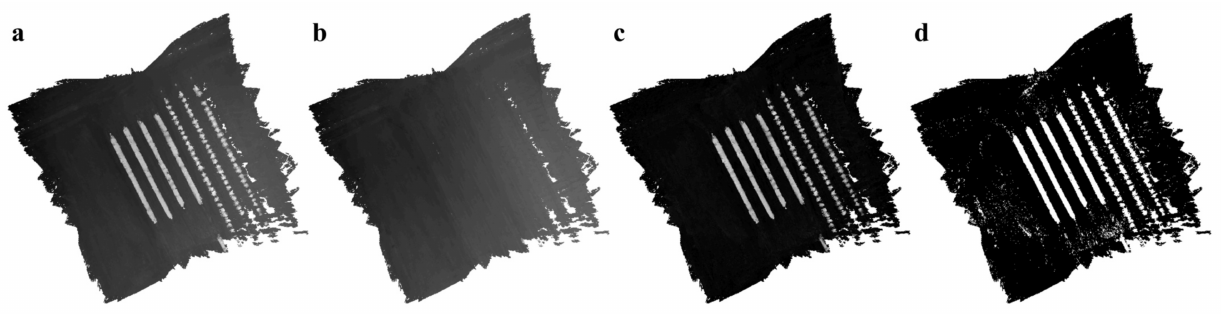
Figure A3. Example height maps and tree mask derived from the downsampled orchard point cloud by a 0.1 m × 0.1 m × 0.1 m terrain grid filter: ( a ) maximum height map; ( b ) minimum height map; ( c ) height difference map; ( d ) tree